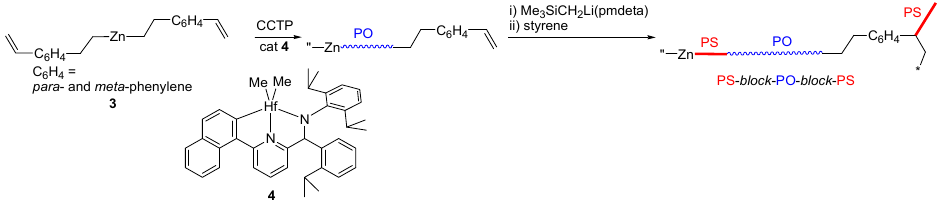
Scheme 2. Strategy employed herein for the preparation of PS- block -PO- block -PS.